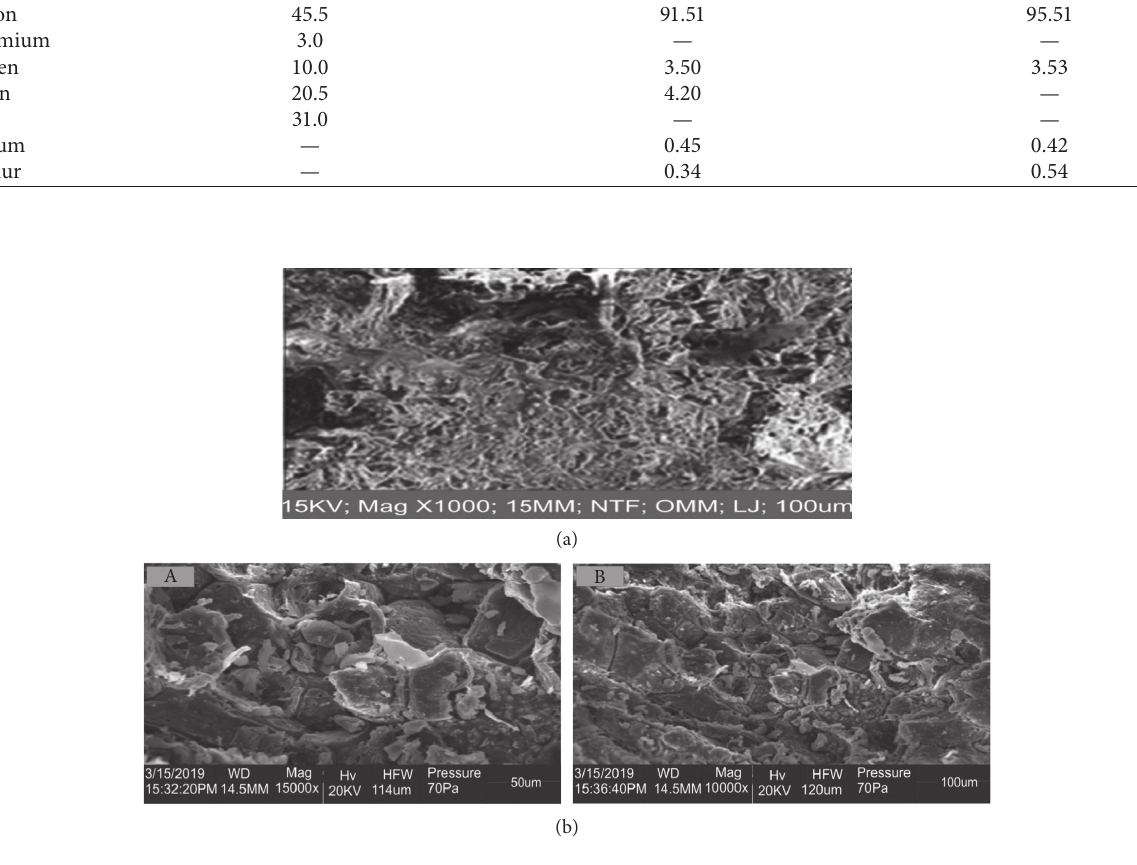
Figure 1: (a) Scanning electron micrograph of Moringa oleifera seed husk activated carbon before adsorption. (b) Scanning electron micrograph of Moringa oleifera seed husk activated carbon after adsorption of trichloromethane and tribromomethane from (A) treated water and (B) raw water